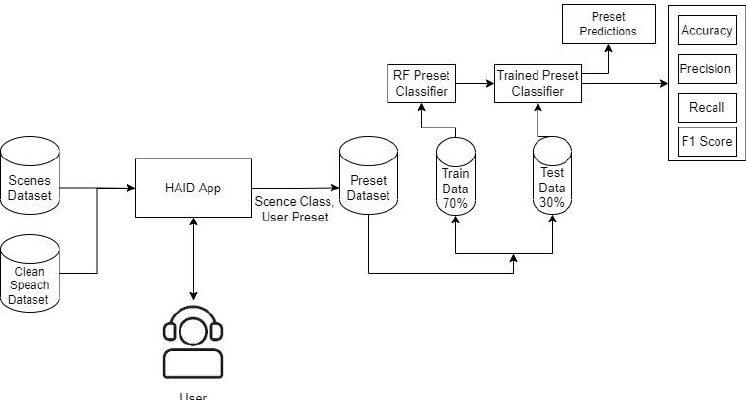
Figure 6. Pre-set training model.